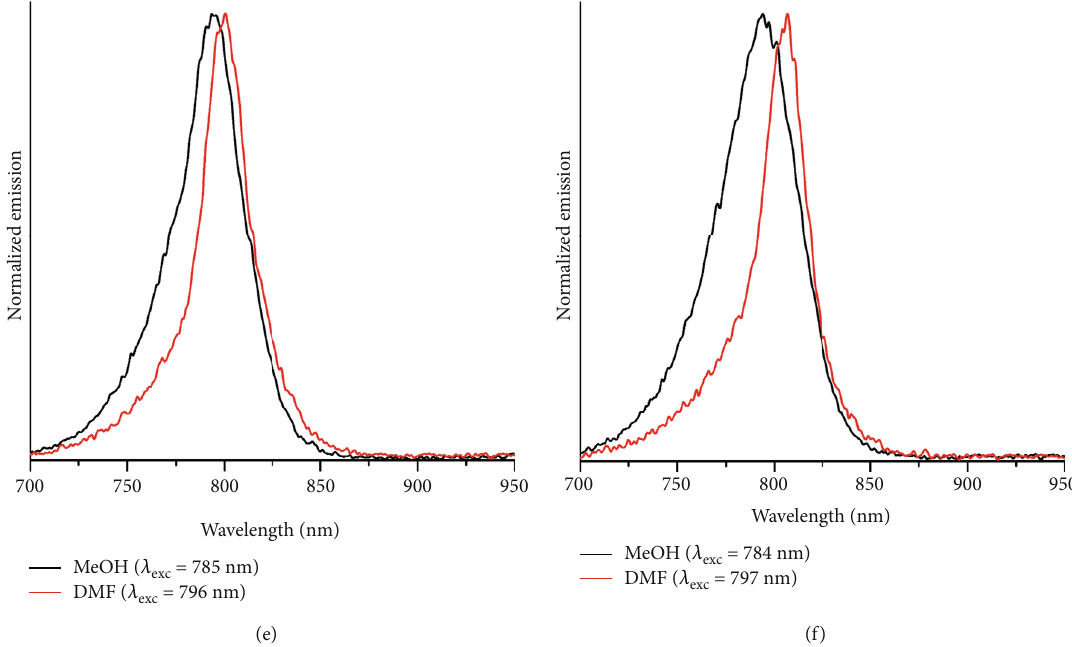
fi lm obtained from di ff erent adsorption methodologies 2 fi lm sensitized under the proposed conditions of methodology #4, with 20mM 2